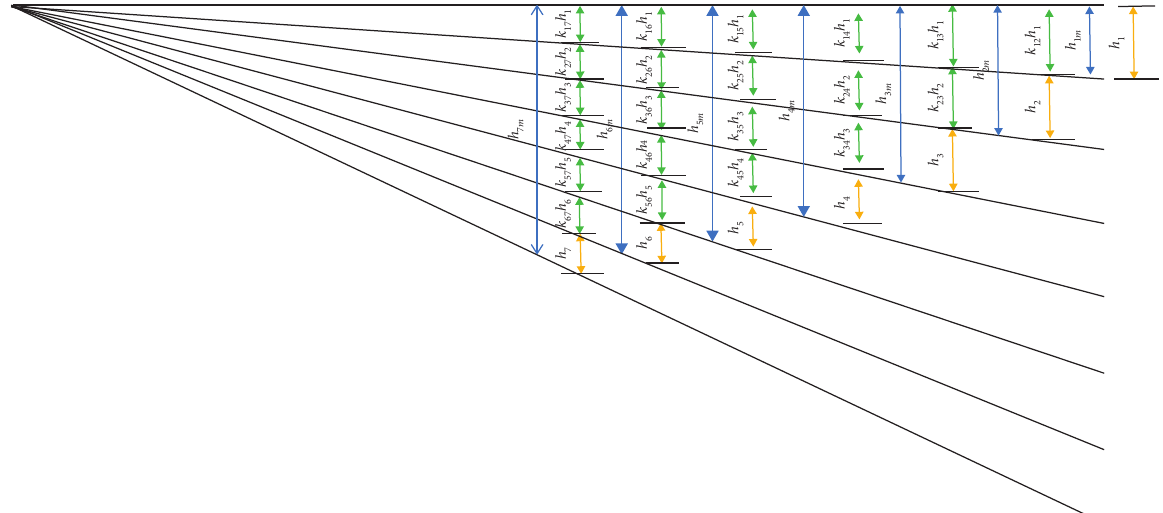
Figure 7: Calculation diagram of total roof subsidence during periodic 4.3.1. Establishing Factor Set. Factor set A is shown in Figure 8.